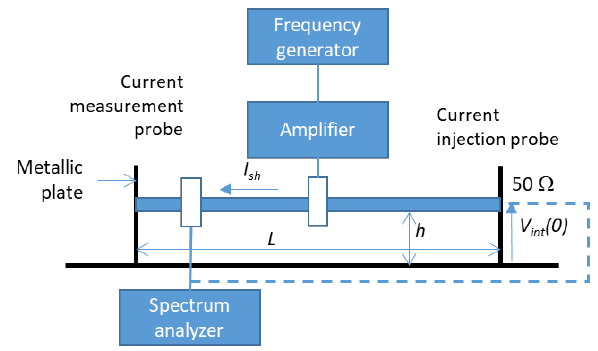
FIGURE 12. Z t scalar measurement setup applied on a RG058 cable (from